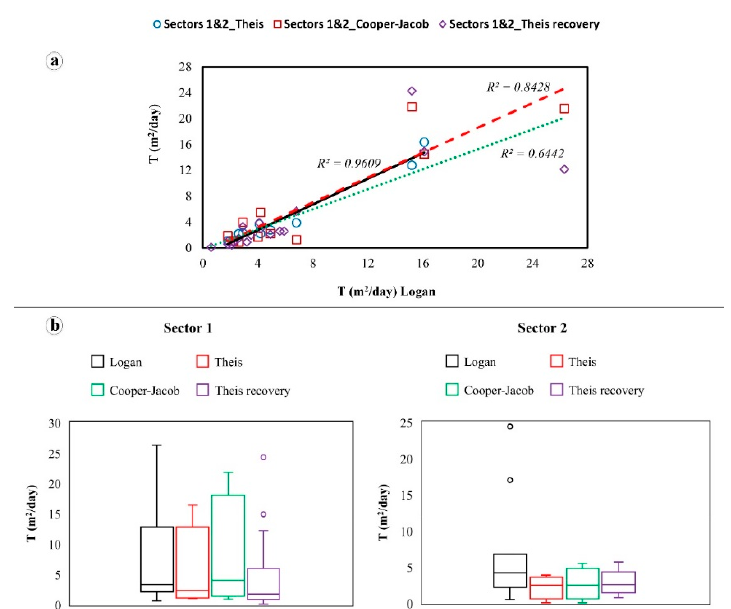
Figure 6. Transmissivity values for Sectors 1 and 2. ( a ) Logan vs. other methods; ( b ) Box-and-whisker diagrams for Sectors 1 and 2.